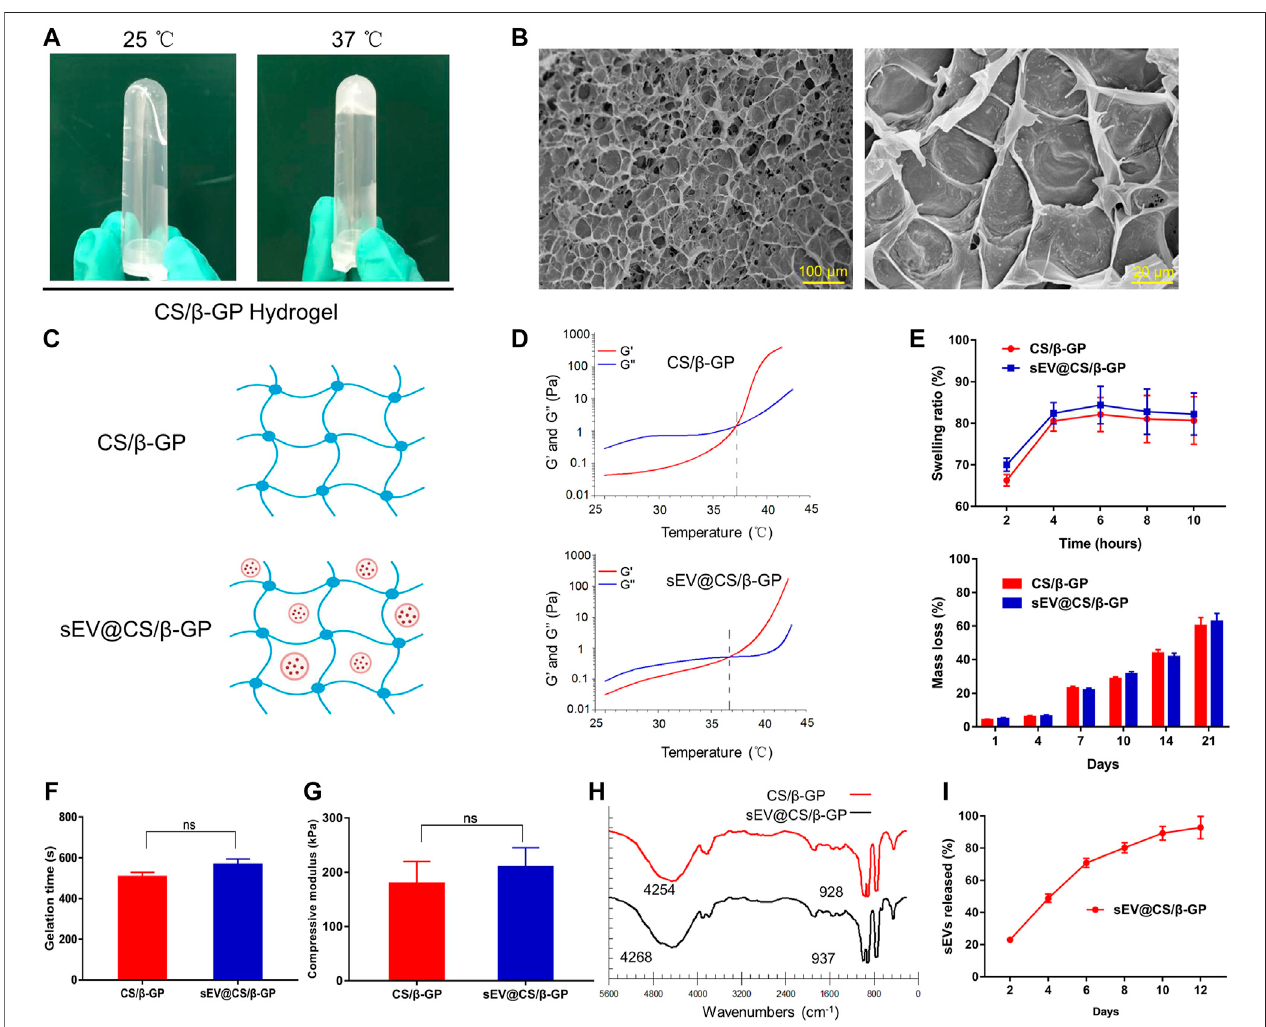
FIGURE 4 | Characterization and the sEV release ability of the CS/ β -GP hydrogel. ns: no signi fi cant difference (A) Sol-to-gel transition: a photograph of CS/ β -GP thermosensitive hydrogel at 25 and 37 ° C (B) SEM photomicrographs of the morphological structure of CS/ β -GP hydrogel (C) Schematic representation of the combinationofsEVsandCS/ β -GPhydrogel (D) Typicaltemperature-dependentfunctionsofG ′ andG ″ forCS/ β -GPandsEV@CS/ β -GPhydrogels (E) Swellingrateand mass-remainingpro fi lesofCS/ β -GPandsEV@CS/ β -GPhydrogels (F) GelationtimeofCS/ β -GPandsEV@CS/ β -GPhydrogels (G) ThecompressivemoduleofCS/ β -GPandsEV@CS/ β -GPhydrogels (H) FTIR(Fourier-transforminfrared)spectraofCS/ β -GPandsEV@CS/ β -GPhydrogels (I) releasepro fi lesofsEVsfromthesEV@CS/ β -GP